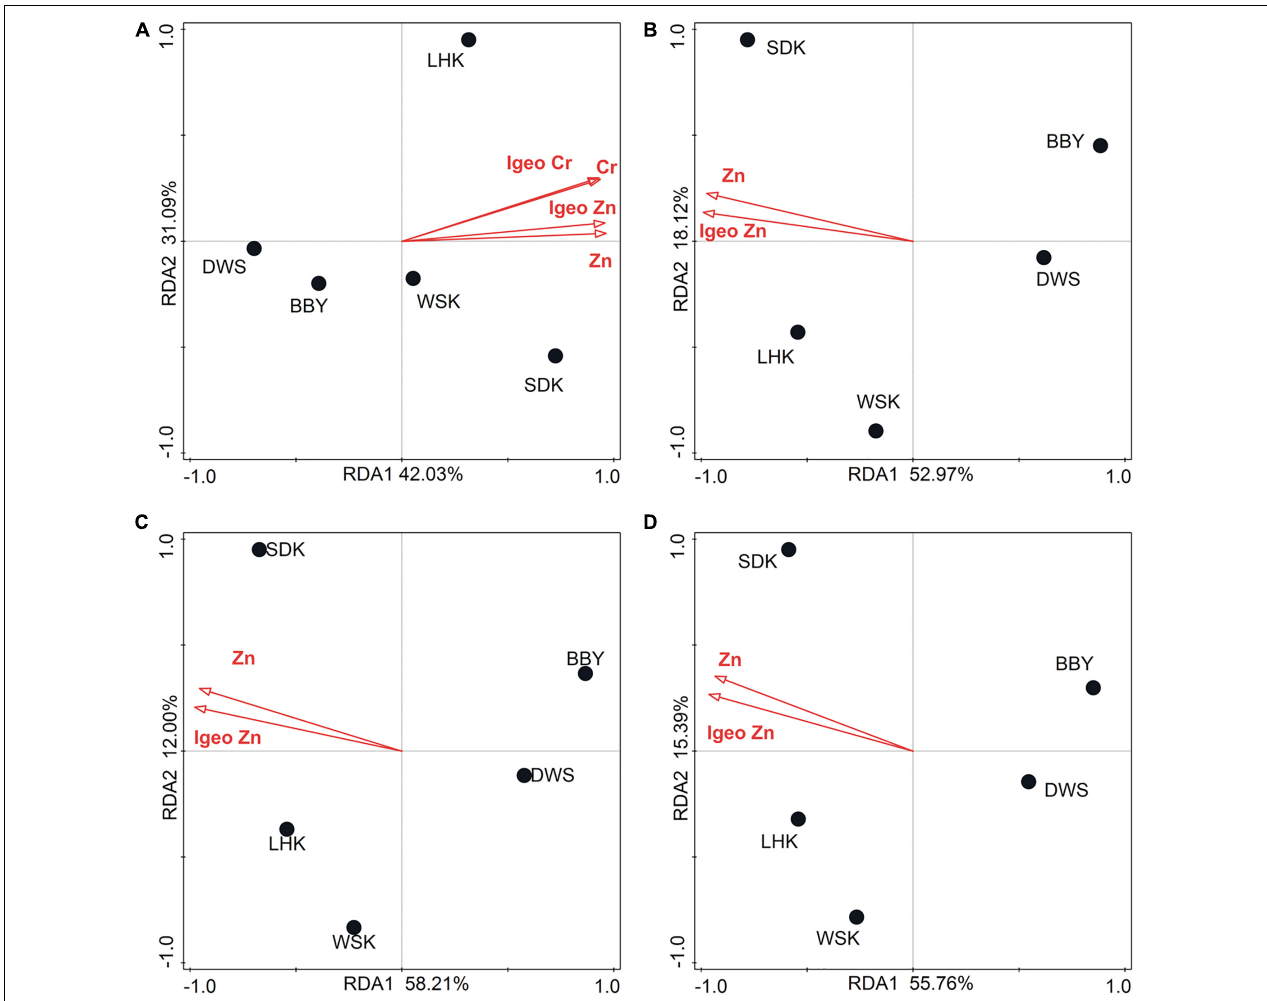
FIGURE 6 | RDA ordination plots of the composition and abundances of dominant bacterial (A) phyla, (B) classes, (C) orders, and (D) families from sediment samples collected in October 2015 in relation to heavy metals and their I geo